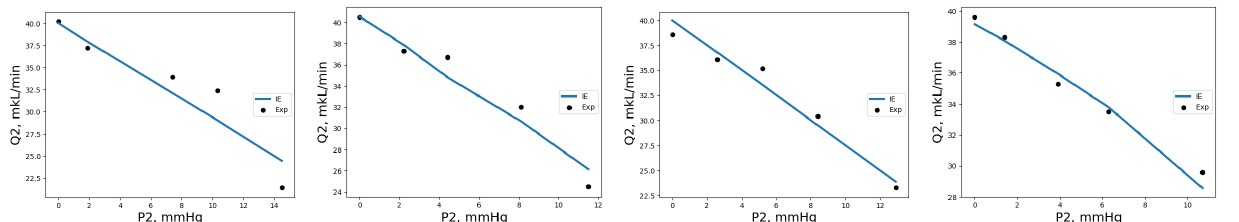
Figure 2. Pressure values P 1 at the inlet opening depending on pressure P 2 at the outlet opening. IE—integral equation model, Exp—experimental data.